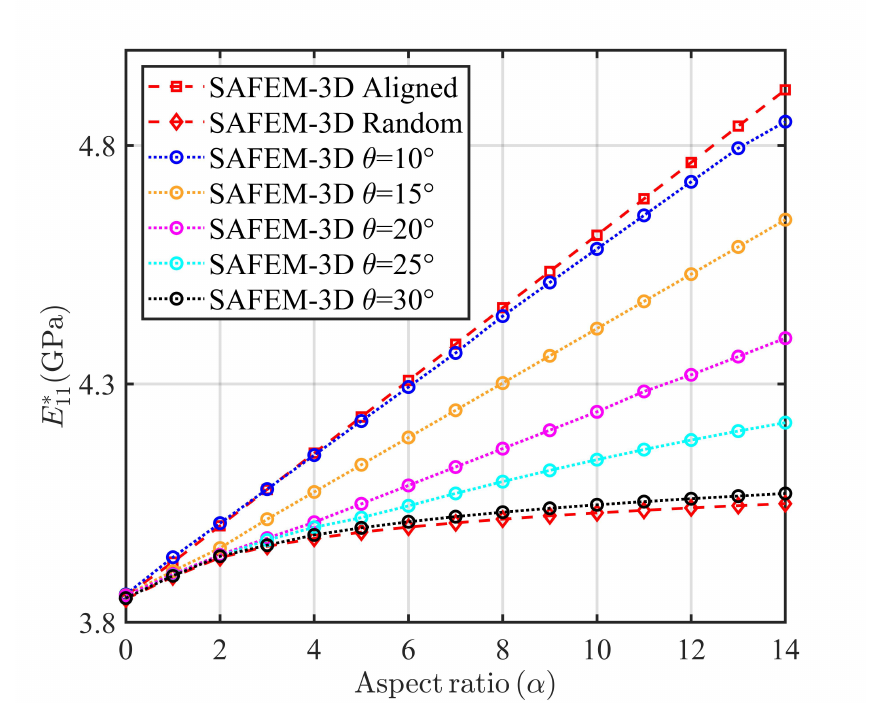
) as a function of the inclusion’s aspect ratio α 11